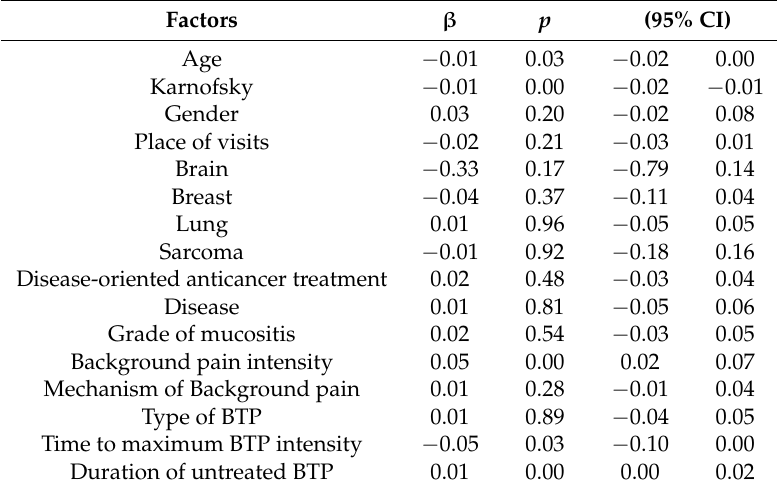
Table 7. Multivariate analysis of factors interfering with daily